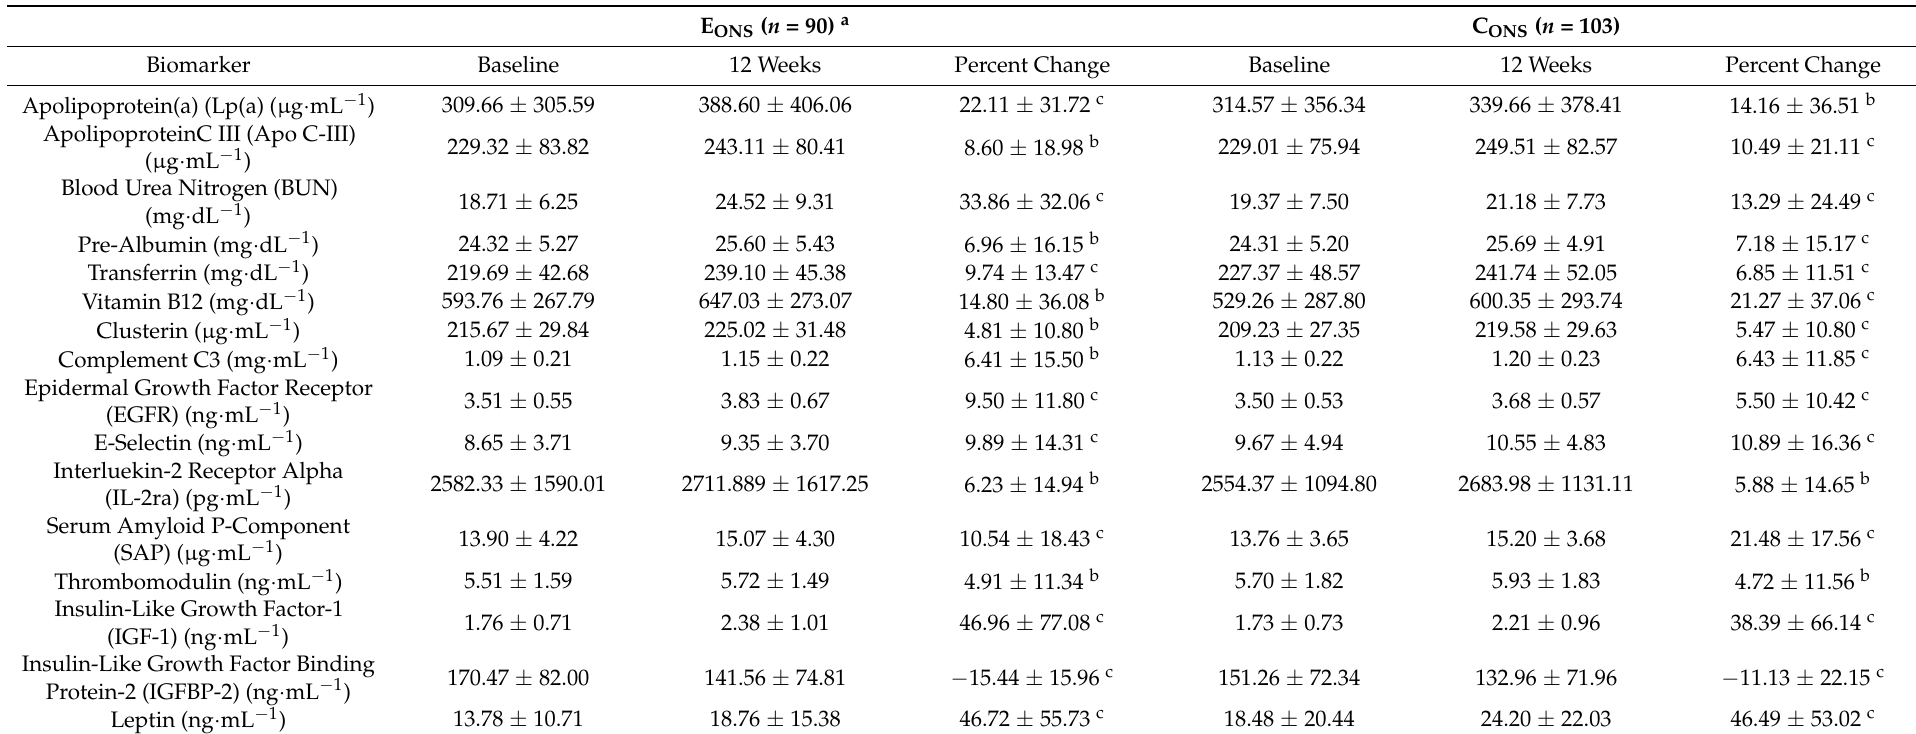
Table 2. Biomarkers common to both treatment groups (E ONS and C ONS ) that significantly changed over 12 weeks of nutritional supplementation. E ONS ( n = 90)